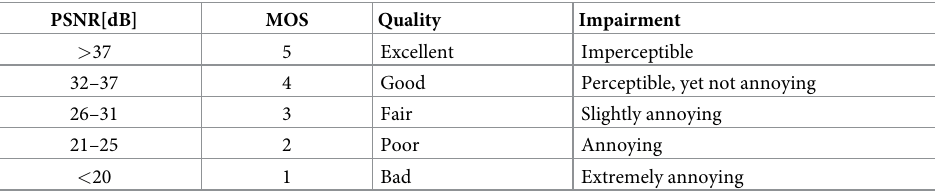
Table 2. PSNR to MOS mapping and ITU-R quality and impairment scales